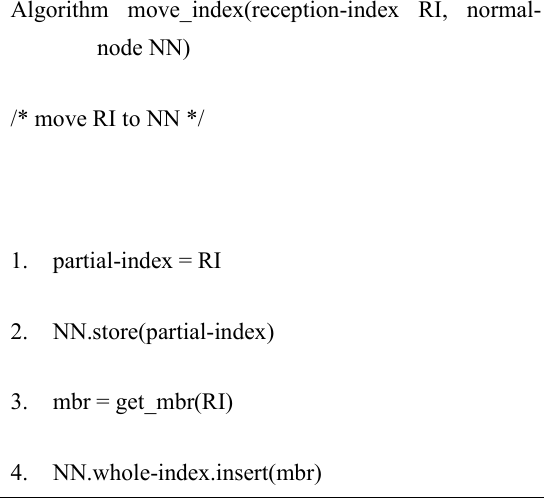
Fig. 5. The algorithm of moving reception-index.